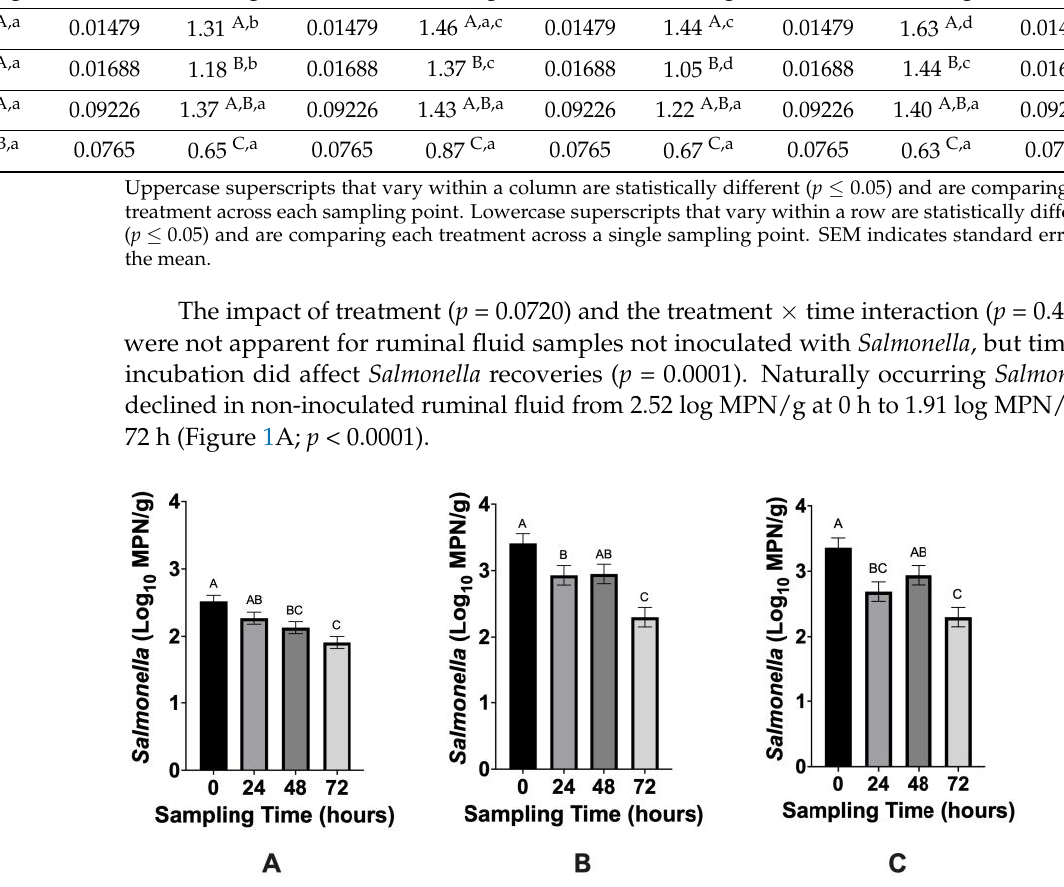
Figure 1. ( A – C ). Mean Salmonella concentration (log 10 MPN/g) in cattle ruminal fluid that is ( A ) non-inoculated, ( B ) inoculated with pansusceptible Salmonella , ( C ) inoculated with Salmonella that is resistant to one or more antibiotics at 0, 24, 48, and 72 h following treatment with varying concentrations of Megasphaera elsdenii as an in vitro model. Error bars represent standard error of the mean. Sampling points with different superscripts are statistically different ( p ≤